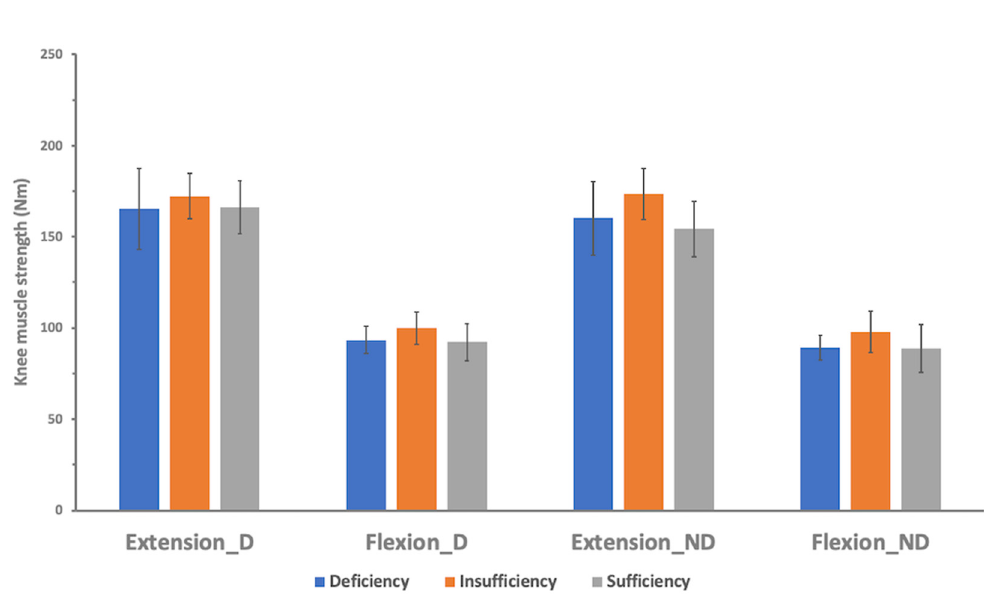
Figure 1. Isokinetic knee muscle strength at 60 ◦ / s according to vitamin D status. The isokinetic knee strengths were not significantly di ff erent across the three groups in all settings (Extension_D, knee extension at dominant side; Flexion_D, knee flexion at dominant side; Extension_ND, knee extension at non-dominant side; Flexion_ND, knee flexion at non-dominant side). Table 4. Comparison of maximal isokinetic ankle strength by vitamin D level.